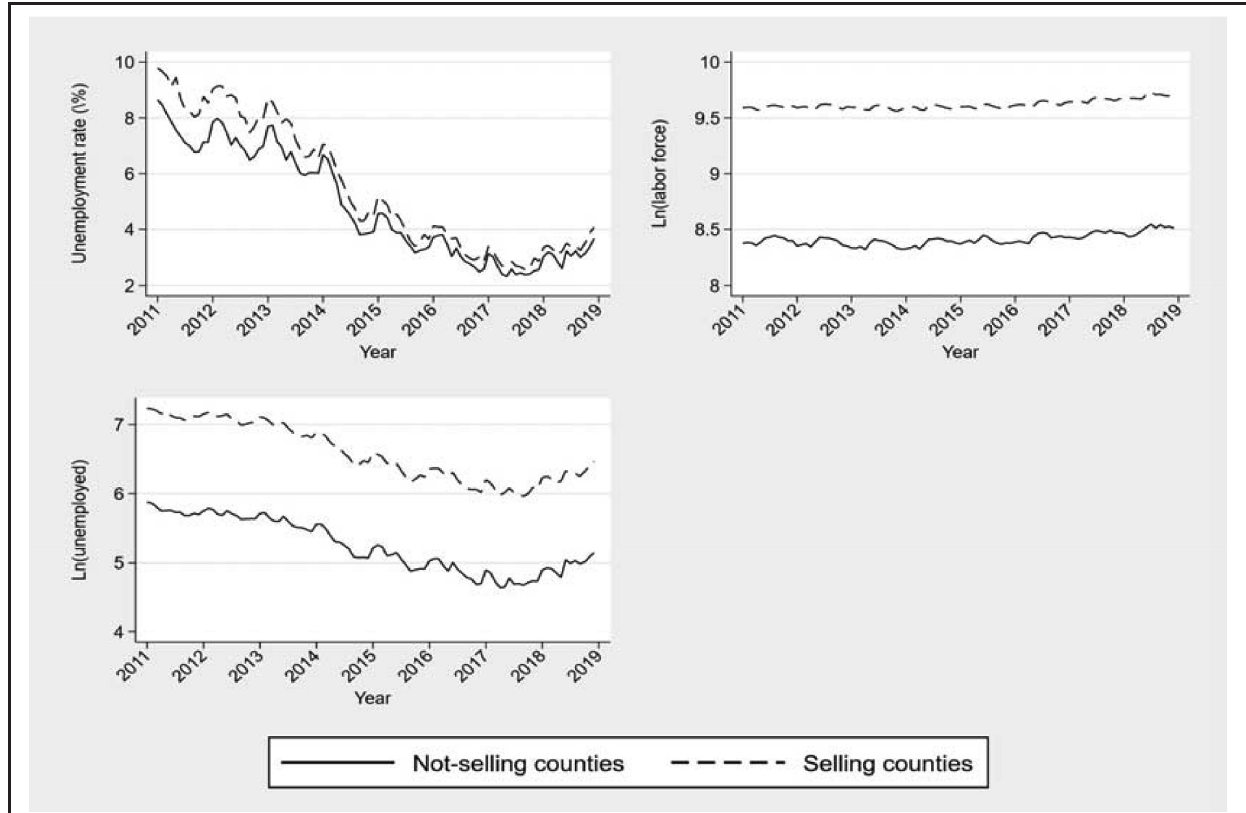
Figure A3 Unemployment rate, Ln(labor force), and Ln(unemployed) over time.